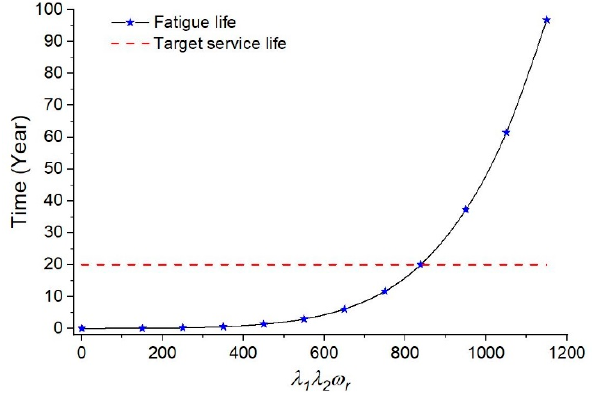
Figure 12. Plots of the fatigue life and configuration parameters λ 1 λ 2 ω r .